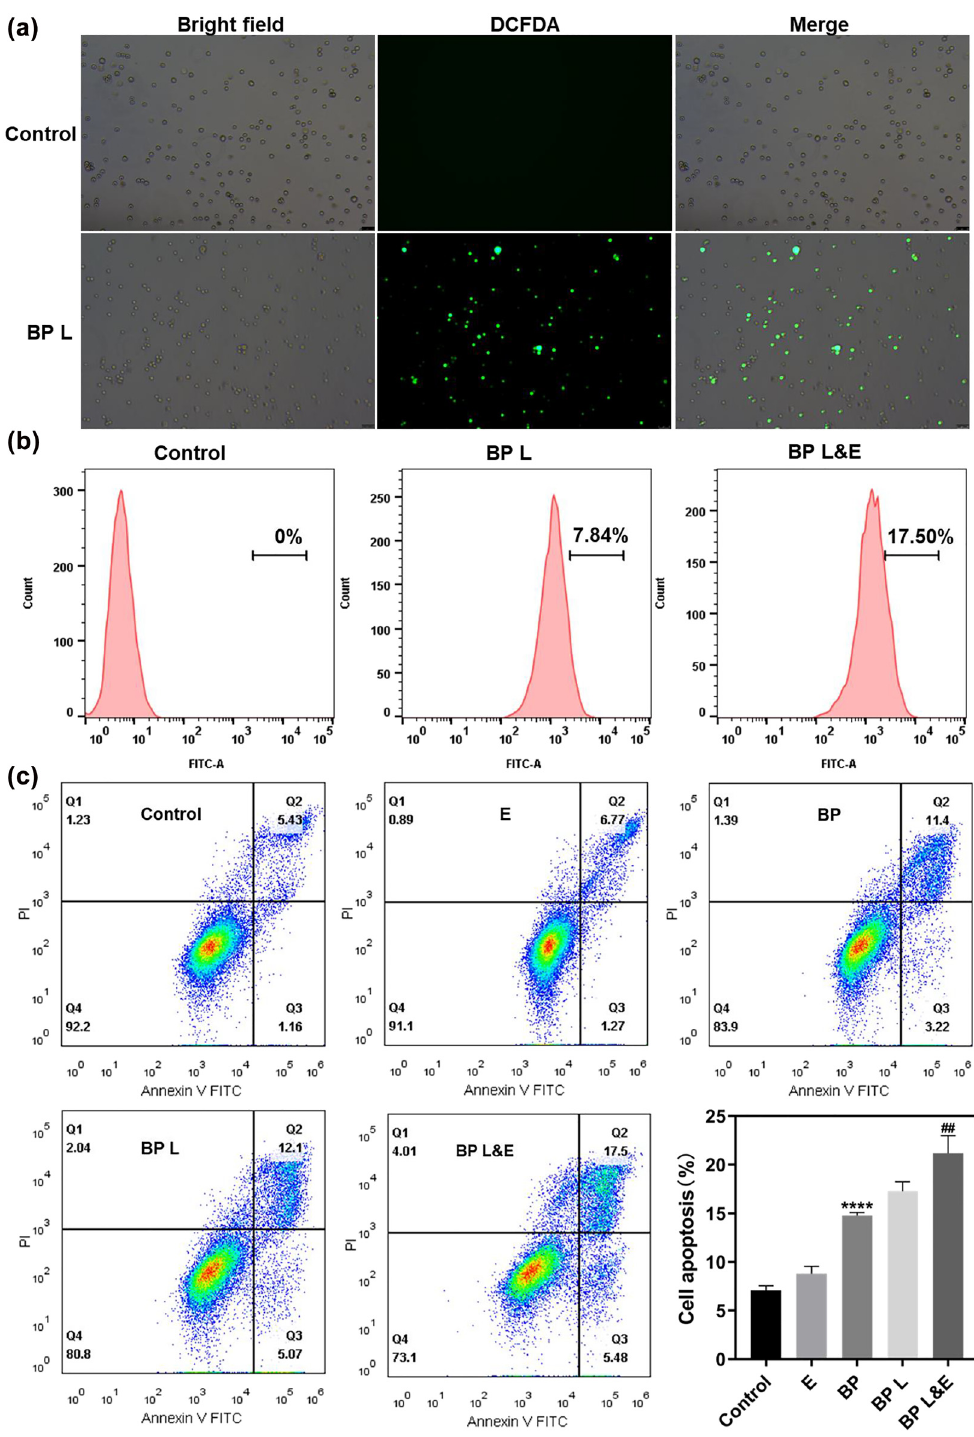
Figure 4: ROS detection and cell apoptotic analysis of BP-PEG in vivo . (a) DCFDA analysis of ROS after laser induced (b) flow cytometric analysis of ROS generation in A549 cells after indicated treatment in the culture medium without glucose. (c) Representative annexin V-FITC/PI scatter plots of A549 cells after 24 h of treatment (the bottom right quadrant displays early apoptotic cells, while the upper right quadrant displays late apoptotic